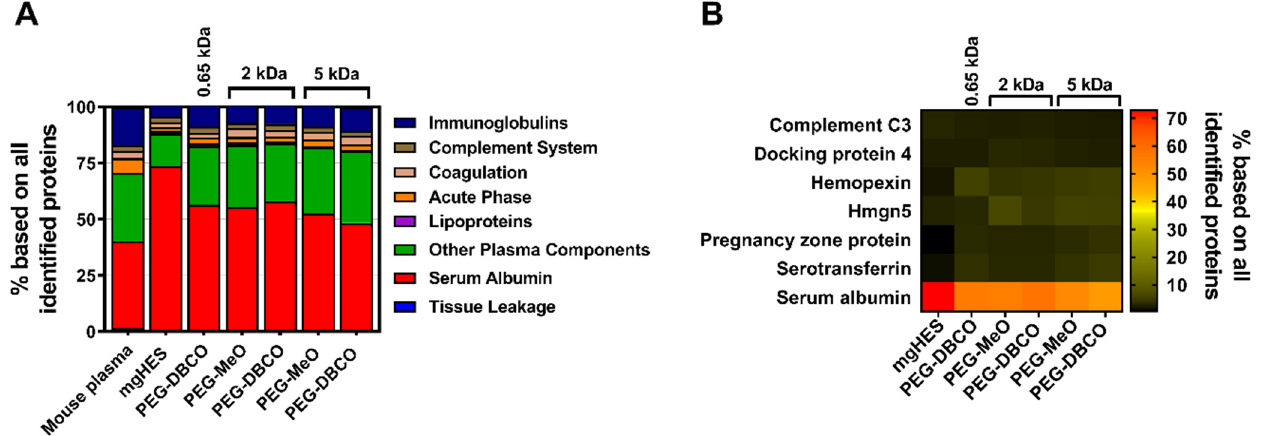
Figure 4. Nanocarrier PEGylation shows little influence on the adsorption profile of the biomolecular protein corona . Adsorbed corona proteins were analyzed by LC-MS and either sorted into eight protein groups ( A ), or individually plotted as a heatmap ( B ). Hmgn5 = High mobility group nucleosome-binding domain-containing protein 5.